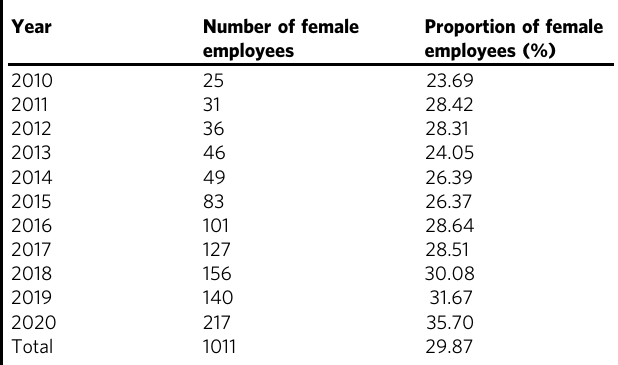
Table 1 Annual distribution of female employees in the